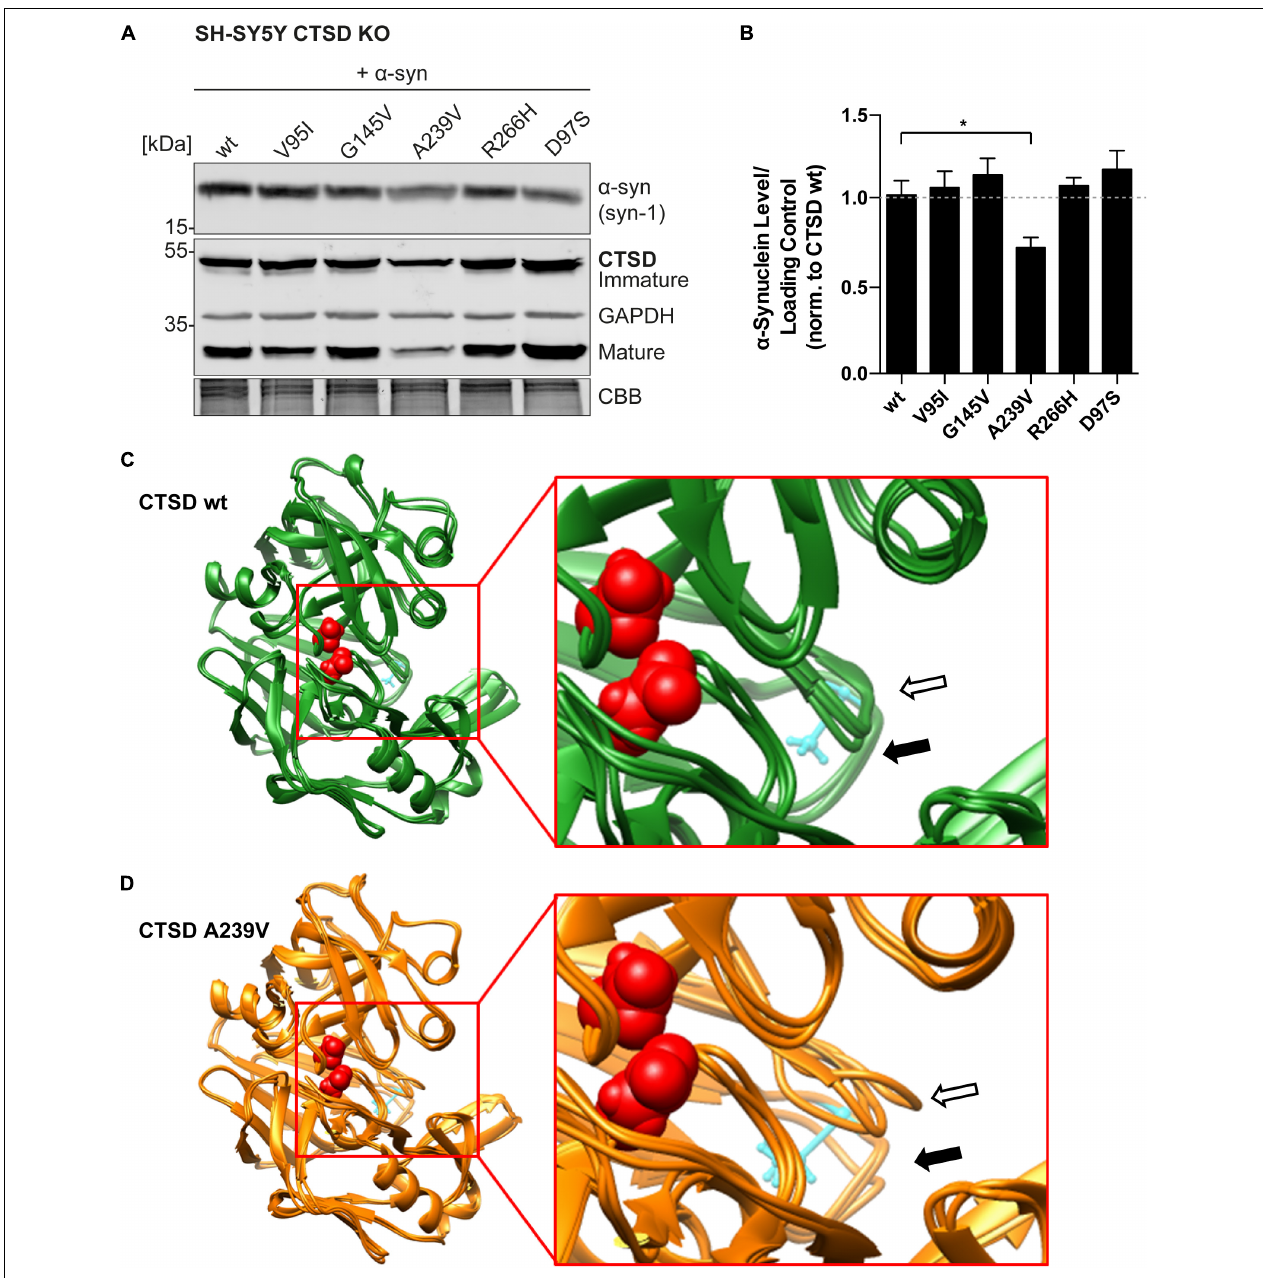
FIGURE 4 | Functional and structural impact of PD-associated CTSD A239V mutation. (A) Immunoblot of CTSD variants co-expressed with a-syn in SH-SY5Y CTSD KO cells. Synuclein-1 (Syn-1) was used for a-syn detection and GAPDH and CBB as loading control. The corresponding whole a-syn western blot can be found in Supplementary Figure 6A . (B) Quantification of a-syn signal intensity after normalization to loading control, shown relative to CTSD wt ( n = 4–7). Statistical analysis was performed using a one-way ANOVA followed by a Tukey’s multiple comparison test. Significances were tested against CTSD wt ( *p < 0.05). (C) Superimposed image of three CTSD wt structures post MDS. The active site residues are shown in red (spacefill) and amino acid A239 is shown in cyan (ball and stick). The loop carrying A239 is marked with a black arrow (filled) and the neighboring loop formed by amino acids 75–77 is marked with an arrow (black unfilled). (D) Superimposed image of three A239-CTSD structures post-MDS. Coloring and annotation with arrows as in (C) . Note the stronger deviation of the two loops when comparing to CTSD